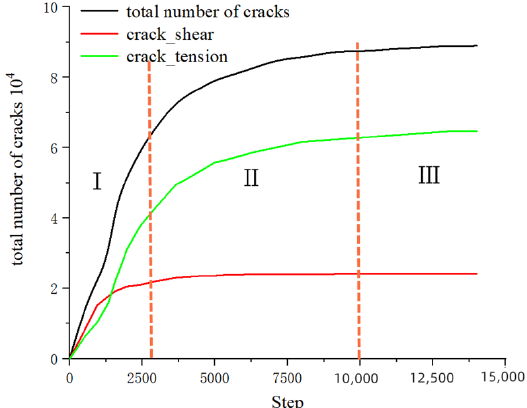
Figure 14. Crack evolution.